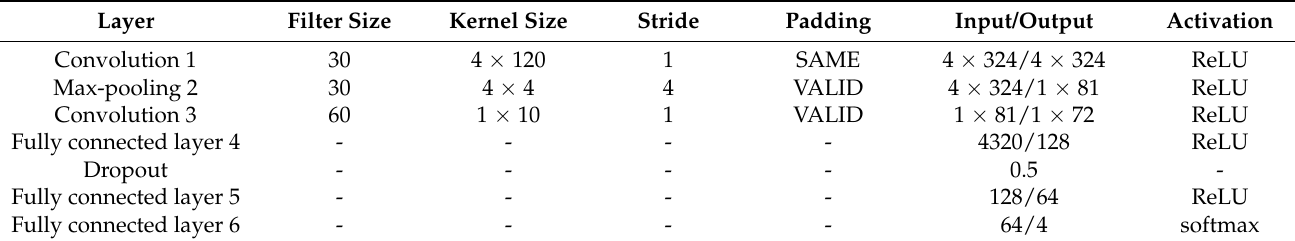
Table 3. Parameters setting of